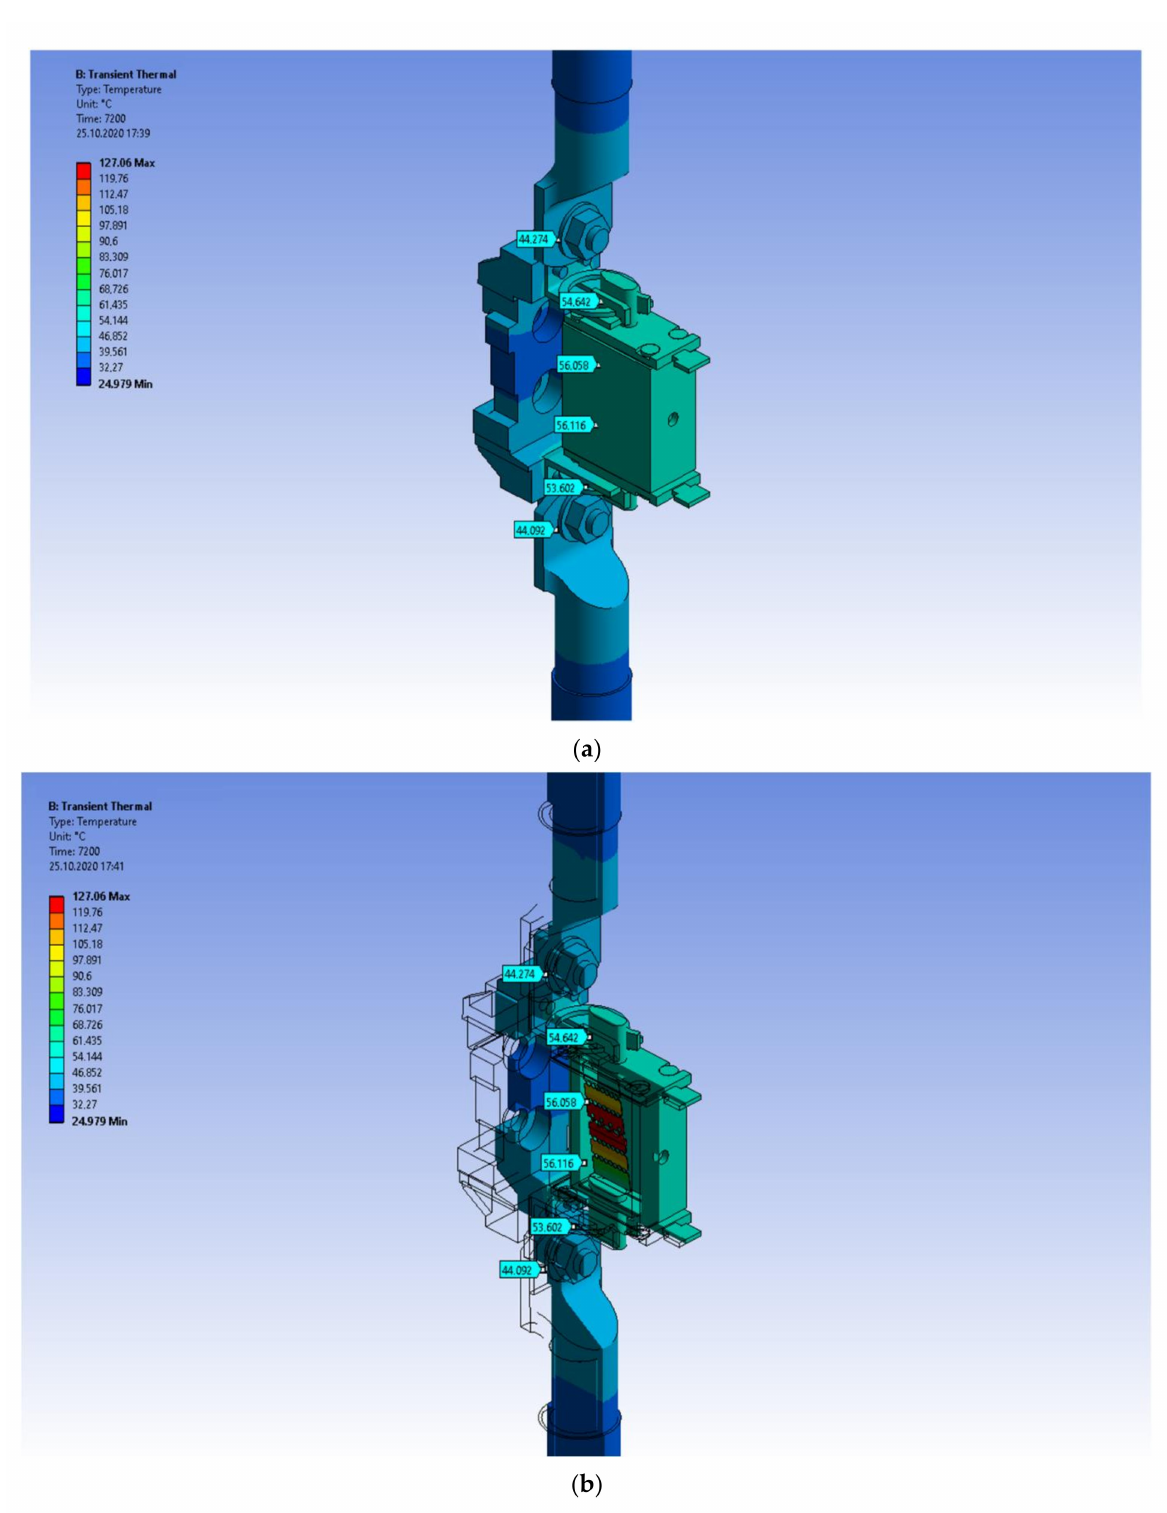
Figure 10. Graphical results of thermal analysis of the fuse link: ( a ) thermal analysis of the fuse link; ( b ) cross-section of the fuse link showing the fusible